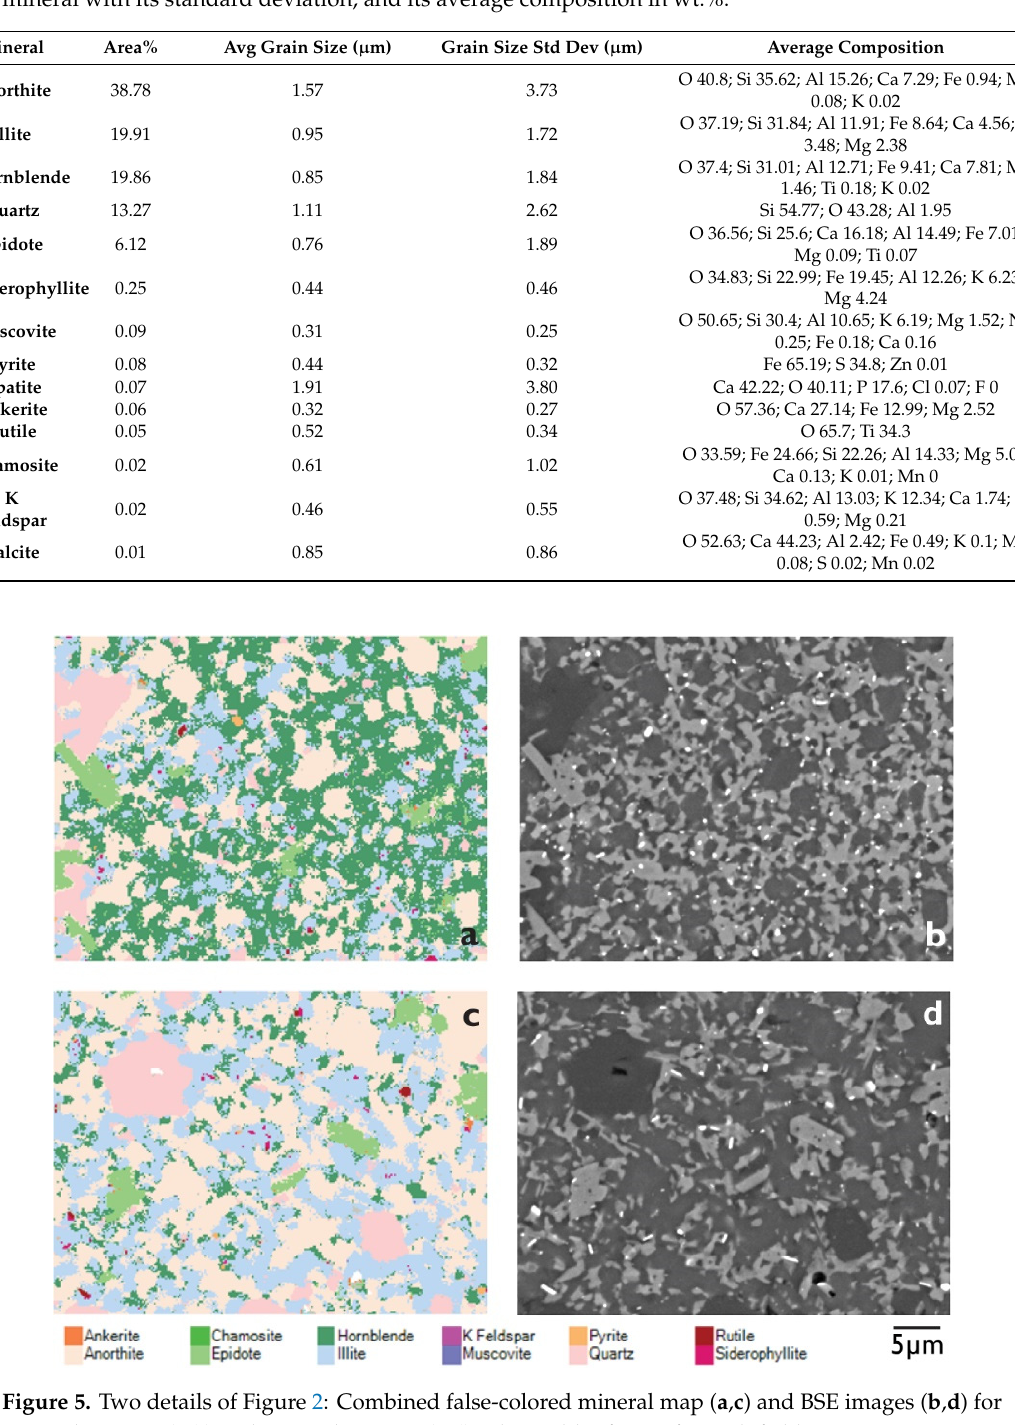
Table 1. Modal mineralogy data from the selected region of interest displayed in the graphical abstract. This data displays the mineral, its area % occurrence in the sample, the average grain size of that mineral with its standard deviation, and its average composition in wt.%.